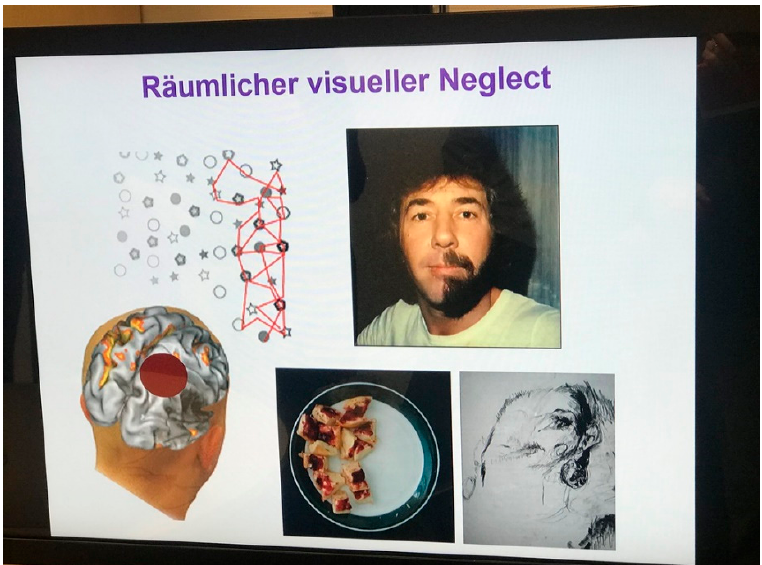
Figure 6. Examples of the consequences of neglect in stroke patients: a plate of food half eaten, a portrait half completed, a face half shaved. In all of these examples, the patient is unaware that anything is abnormal or missing. The top left shows eye tracking attention being drawn to the right, which is explained below.